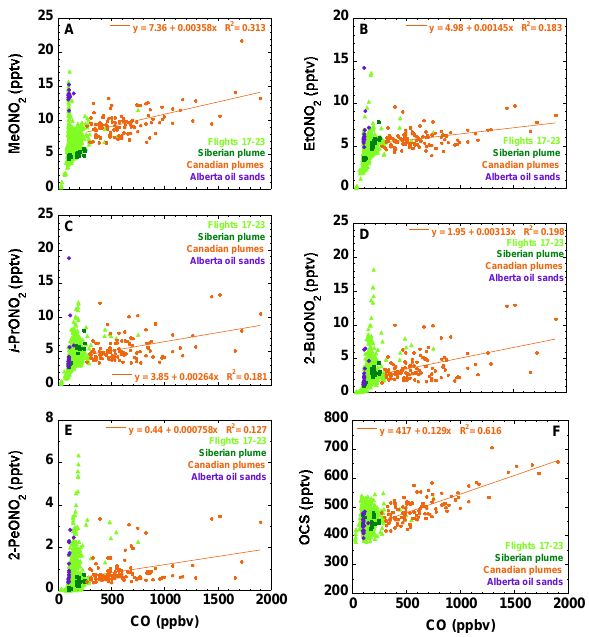
Figure 10. As in Figure 4 but for the six halocarbons that were released from the fires. Fig. 10. As in Fig. 4 but for the six halocarbons that were released Dibromomethane (CH 2 Br 2 ) has been included despite high plume-to-plume variability (see text). from the fires. Dibromomethane (CH 2 Br 2 ) has been included de- spite high plume-to-plume variability (see text).